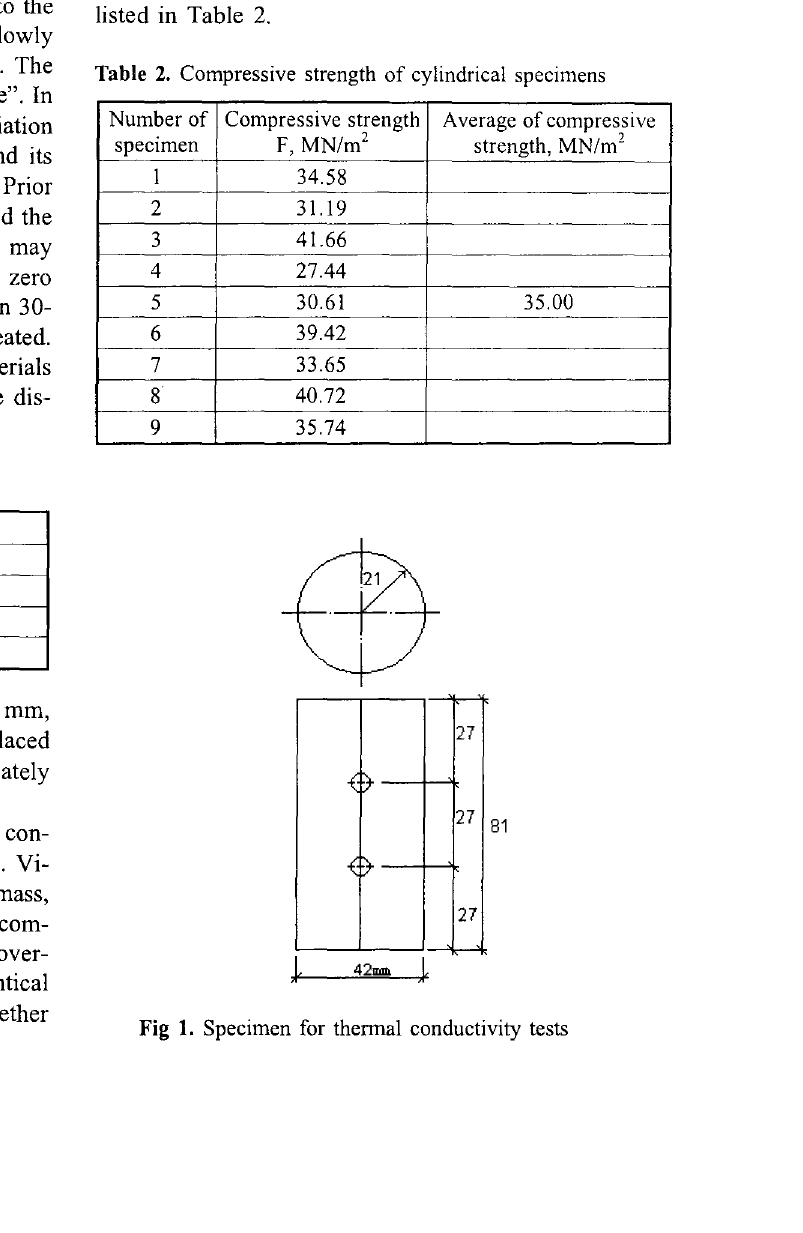
Fig 1. Specimen for thermal conductivity